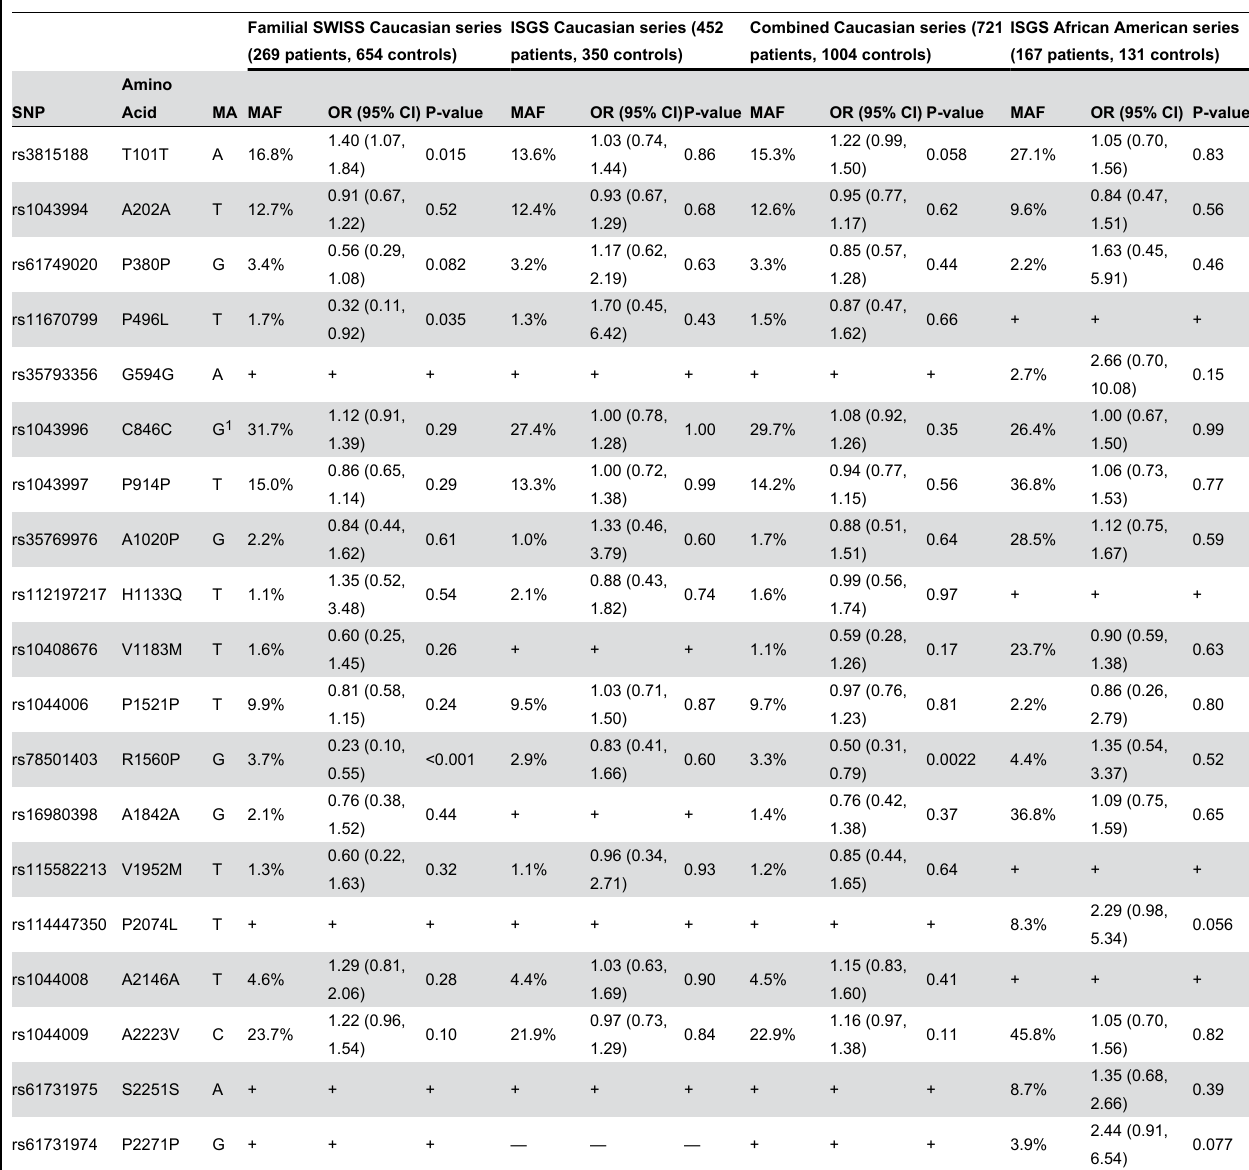
1 The minor allele for rs1043996 was G in the Caucasian series’ and A in the ISGS African American series. + indicates that the SNP was observed with a minor allele frequency of less than 1% or greater in the given series. --- indicates that the SNP was not observed in the given series. ORs and p-values result from logistic regression models adjusted for age and gender (Familial Caucasian series), age, gender, atrial fibrillation, coronary artery disease, diabetes, hypertension, and current smoking (ISGS Caucasian series), age, gender, and series (combined Caucasian series), and age, gender, coronary artery disease, diabetes, hypertension, and current smoking (ISGS African American series). ORs correspond to an additional minor allele. SNP=single nucleotide polymorphism. MA=minor allele. MAF=minor allele frequency. OR=odds ratio. CI=confidence interval. ISGS=Ischemic Stroke Genetics